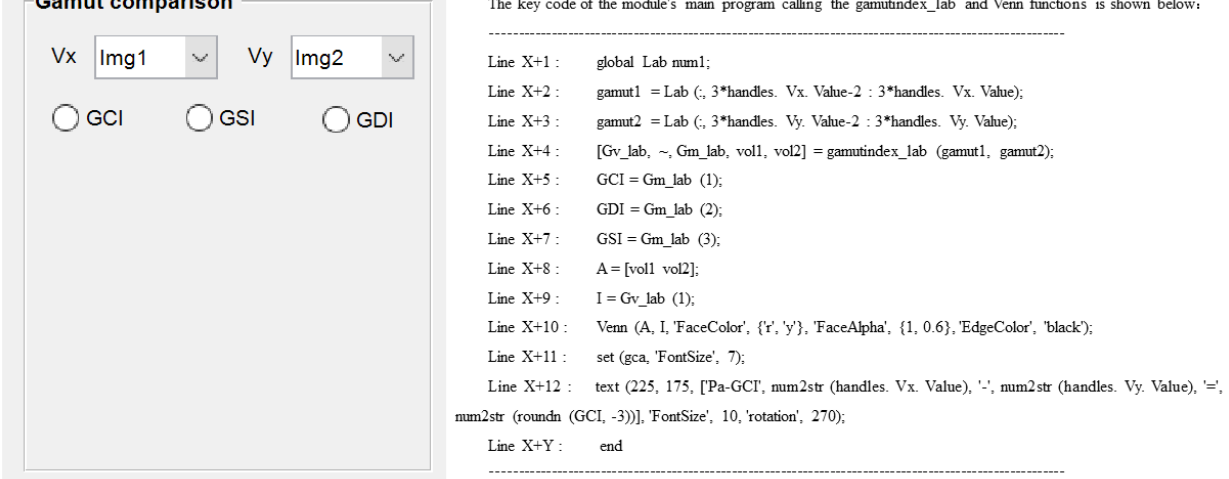
Figure 15. Interface design and demonstration of its calling codes in Module 5. Table 5. Types, labels and roles of controls used in the Module 5